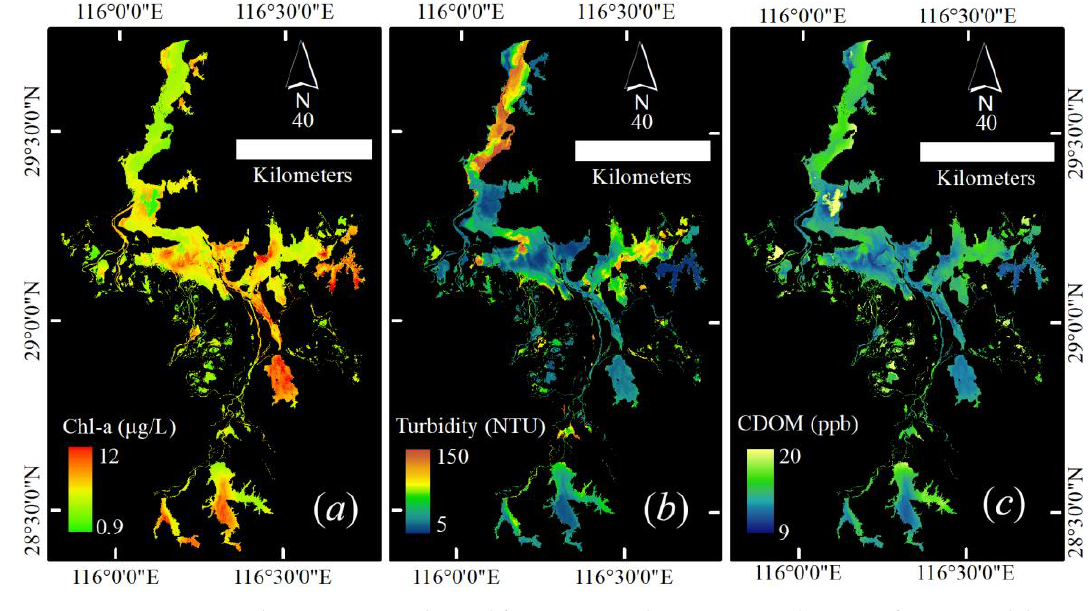
Figure 14. Water quality parameters derived from OLI / Landsat 8 on 5 October 2013, for Poyang lake. ( a ) Chl-a, ( b ) turbidity, ( c ) CDOM.